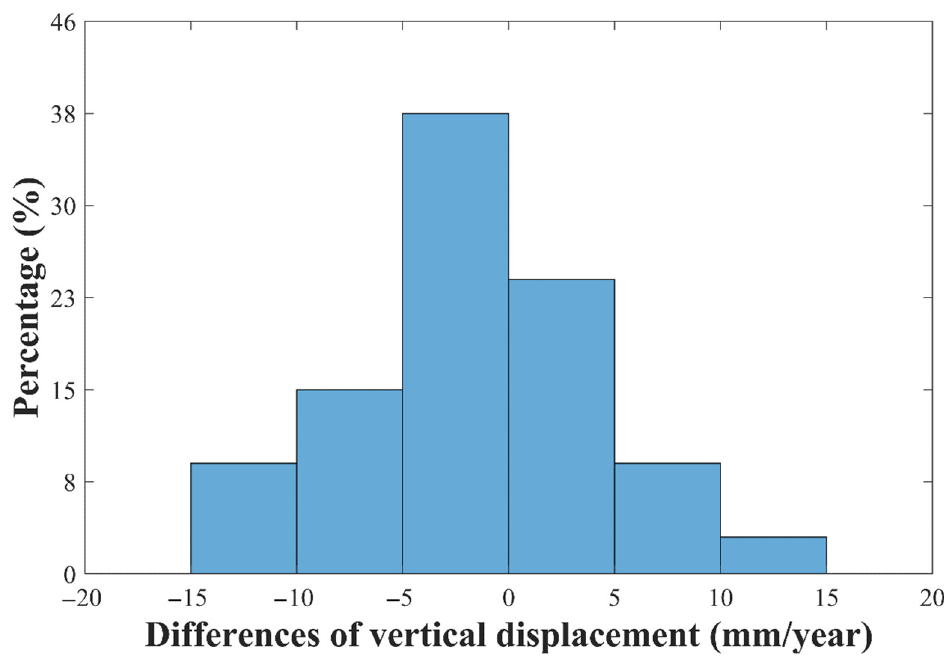
Figure 9. Cross validation based on the differences between the projected vertical displacements from the descending and ascending InSAR measurements.